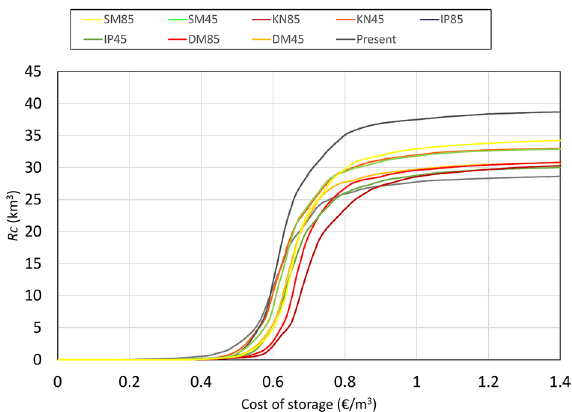
Figure 5. Cumulate runoff versus the cost of storage per unit of runoff, for a storage cost of 50 € m −3 . Different climatic scenarios are